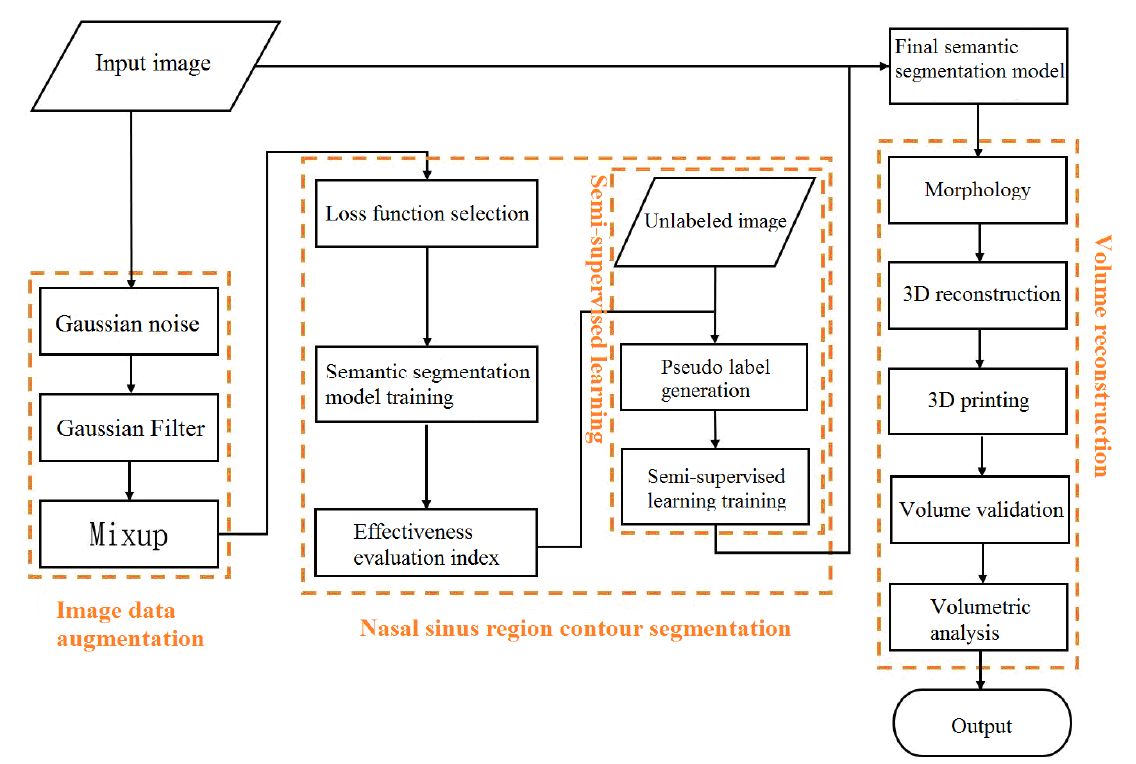
Figure 10. Experimental system flow chart.